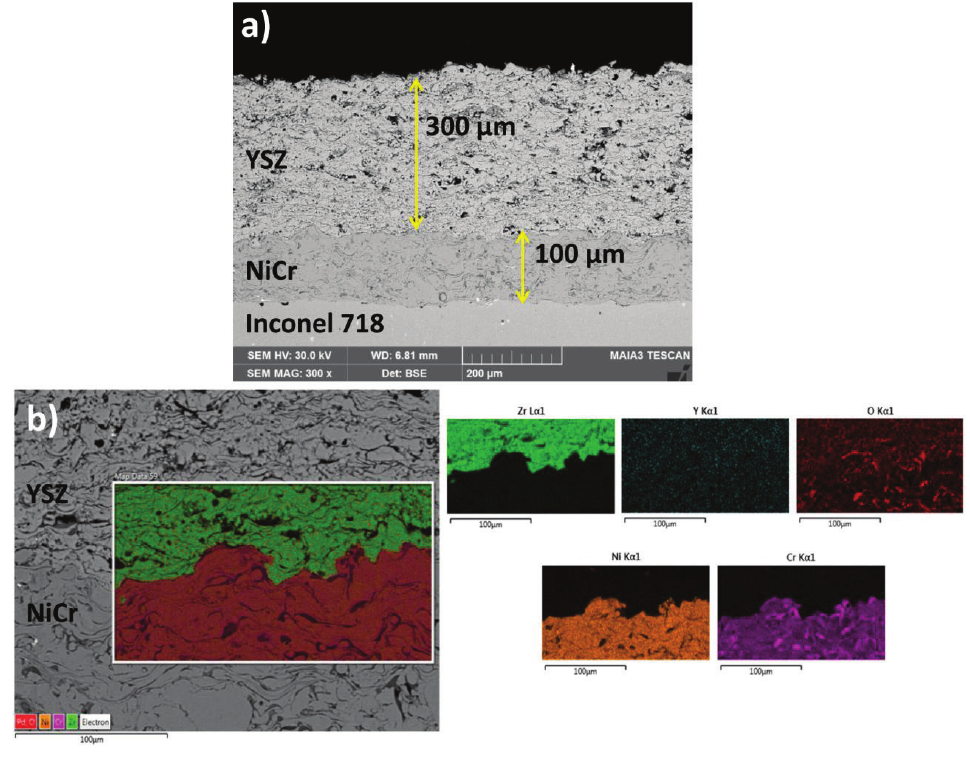
Figure 2: As-deposited TBC SEM and elemental mapping microstructures. YSZ has an ionic conductivity due to the its crystal structure. At high temperature, oxygen diffuses from top coat to bond coat with affecting both, YSZ structure and existing porosities [16,17]. Cr is more reactive compared to Ni according to Ellingham diagrams [18]. For this reason, Cr first reacts with oxygen forming protective Cr 2 O 3 layer at the interface during this oxidation reaction. Cr 2 O 3 layer acts as an oxygen barrier and that is why TGO layer mainly consists of Cr 2 O 3 phase considering all oxidation periods [19,20].